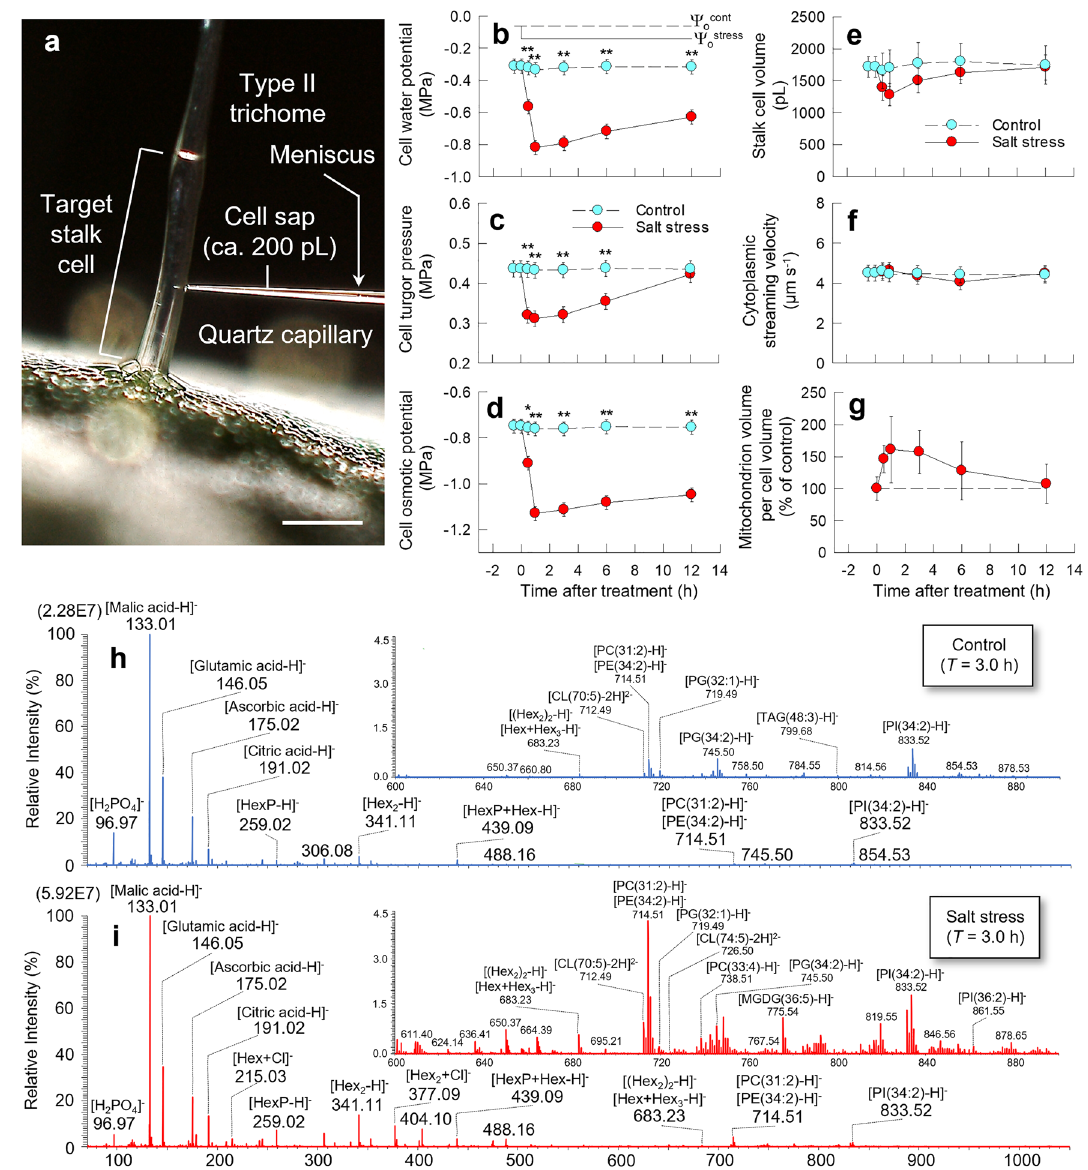
Figure 1. Time-course of changes in cellular parameters and picoPPESI negative ion mode mass spectra in tomato trichome stalk cells under salt stress conditions. An image of tip insertion into the stalk cells ( a ). Changes in the media water potential and cell water potential (Ψ w ) ( b ), cell turgor (Ψ p ) ( c ), cell osmotic potential (Ψ s ) ( d ), cell volume ( V o ) ( e ), cytoplasmic streaming velocity ( f ), mitochondrion volume per the cell volume ( V Mito / V o ) ( g ) under salt stress conditions. PicoPPESI negative ion mode mass spectra obtained from the stalk cells under control and salt stress conditions at 3 h ( h and i ). Cyan and red plots indicate control and salt stress treatment, respectively. Bar = 200 μm. For Ψ w , Ψ p , Ψ s , and cytoplasmic streaming velocity, data are means ± SE for 3–32 cells from 3 to 6 plants in each treatment ( b , c , d , and f ). ( e ) The V o data are means ± SE for 11–16 cells from 3 to 6 plants in each treatment. ( g ) The V Mito / V o data is means ± SE for 5–12 cells from 3 to 6 plants in each treatment. Significant difference at the 0.01 and 0.001 probability levels by t -test is indicated with * and **, respectively. The data represent repeated experiments with 8–32 stalk cells in total from 3 to 6 plants in each treatment ( h and i ). Hex: hexose; HexP: hexose phosphate; CL: cardiolipin; PC: phosphatidylcholine; PE: phosphatidylethanolamine; PI: phosphatidylinositol; PG: phosphatidylglycerol; TAG: triacylglycerol; PS: phosphatidylserine; MGDG: monogalactosyl diacylglycerol. Line graphs were created with Sigmaplot